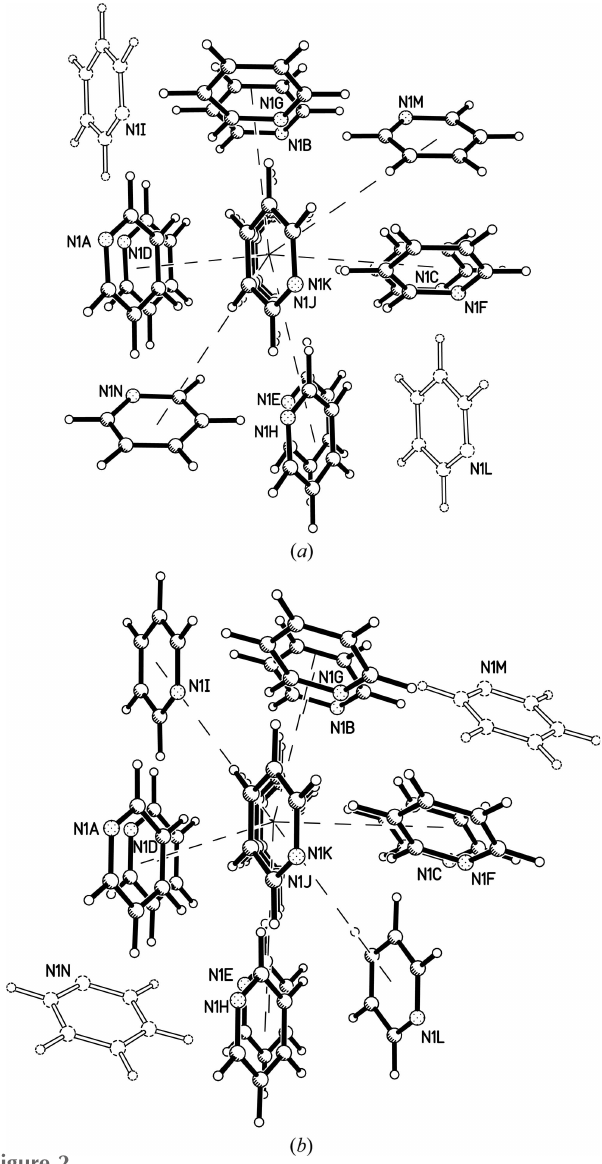
Figure 2 First coordination spheres of ( a ) pyridine II at 1.09 GPa and ( b ) pyridine III at 1.69 GPa. The molecules described in the text as forming long interactions are shown as